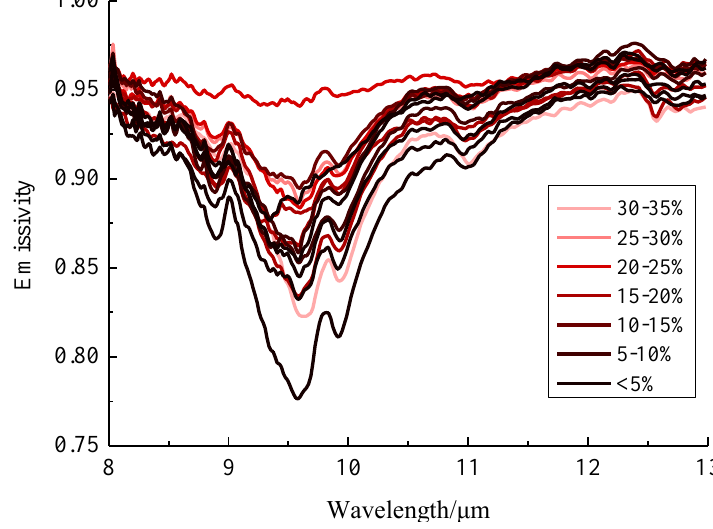
Figure 7. Thermal infrared spectra of the test samples.